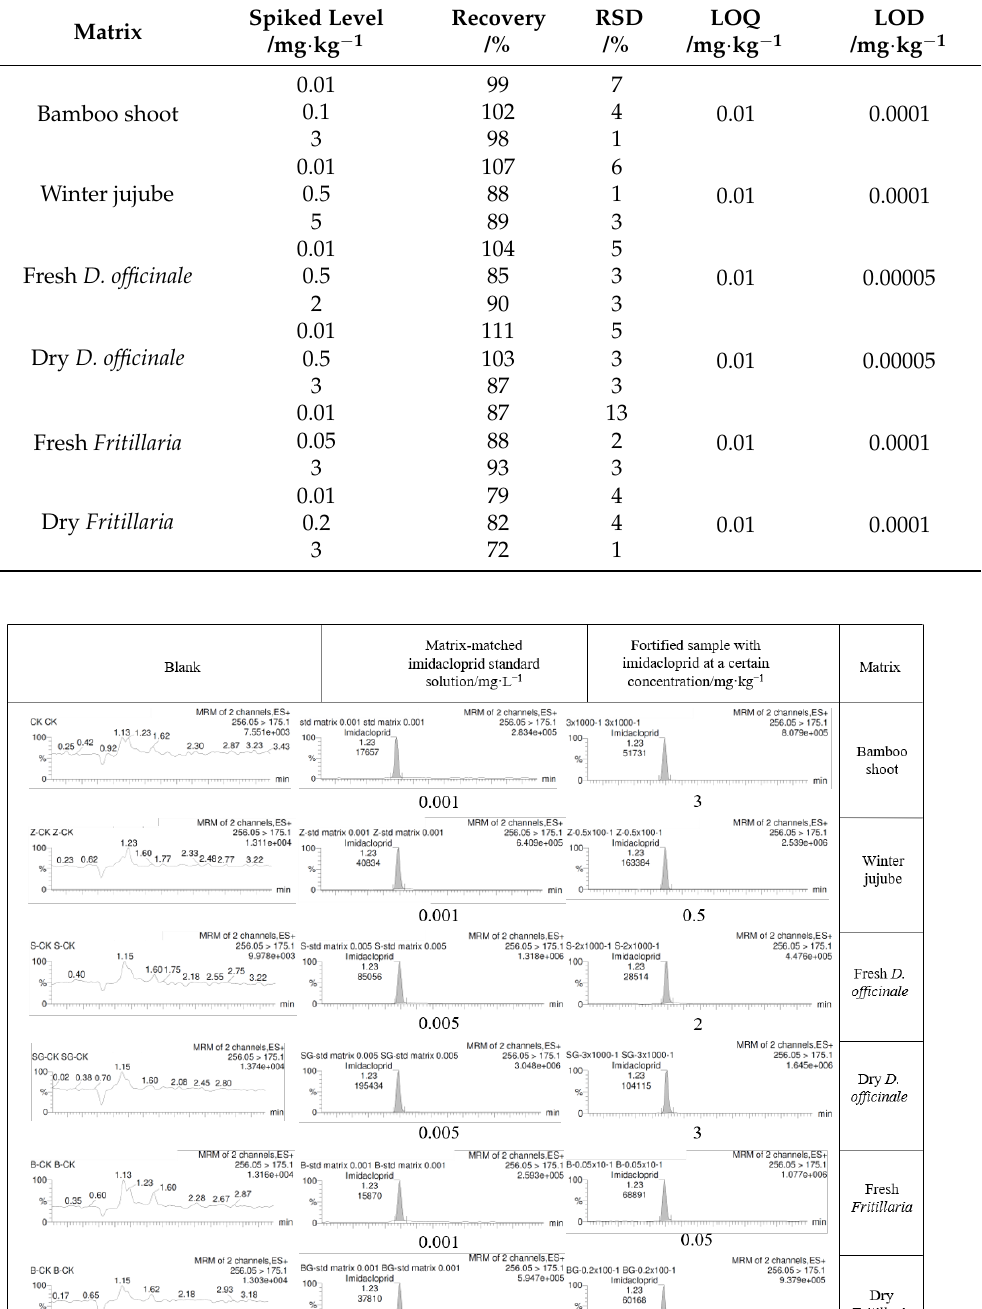
Table 2. Recovery, relative standard deviation (RSD), limit of quantitation (LOQ), and limit of detection (LOD) for imidacloprid in three spiked levels from bamboo shoot, winter jujube, fresh and dry D. officinale , and fresh and dry Fritillaria .